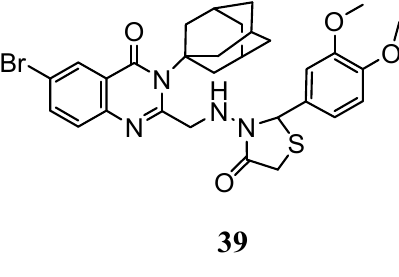
Figure 5 . Docking of the most active compound 4 h in the active site of BACE1